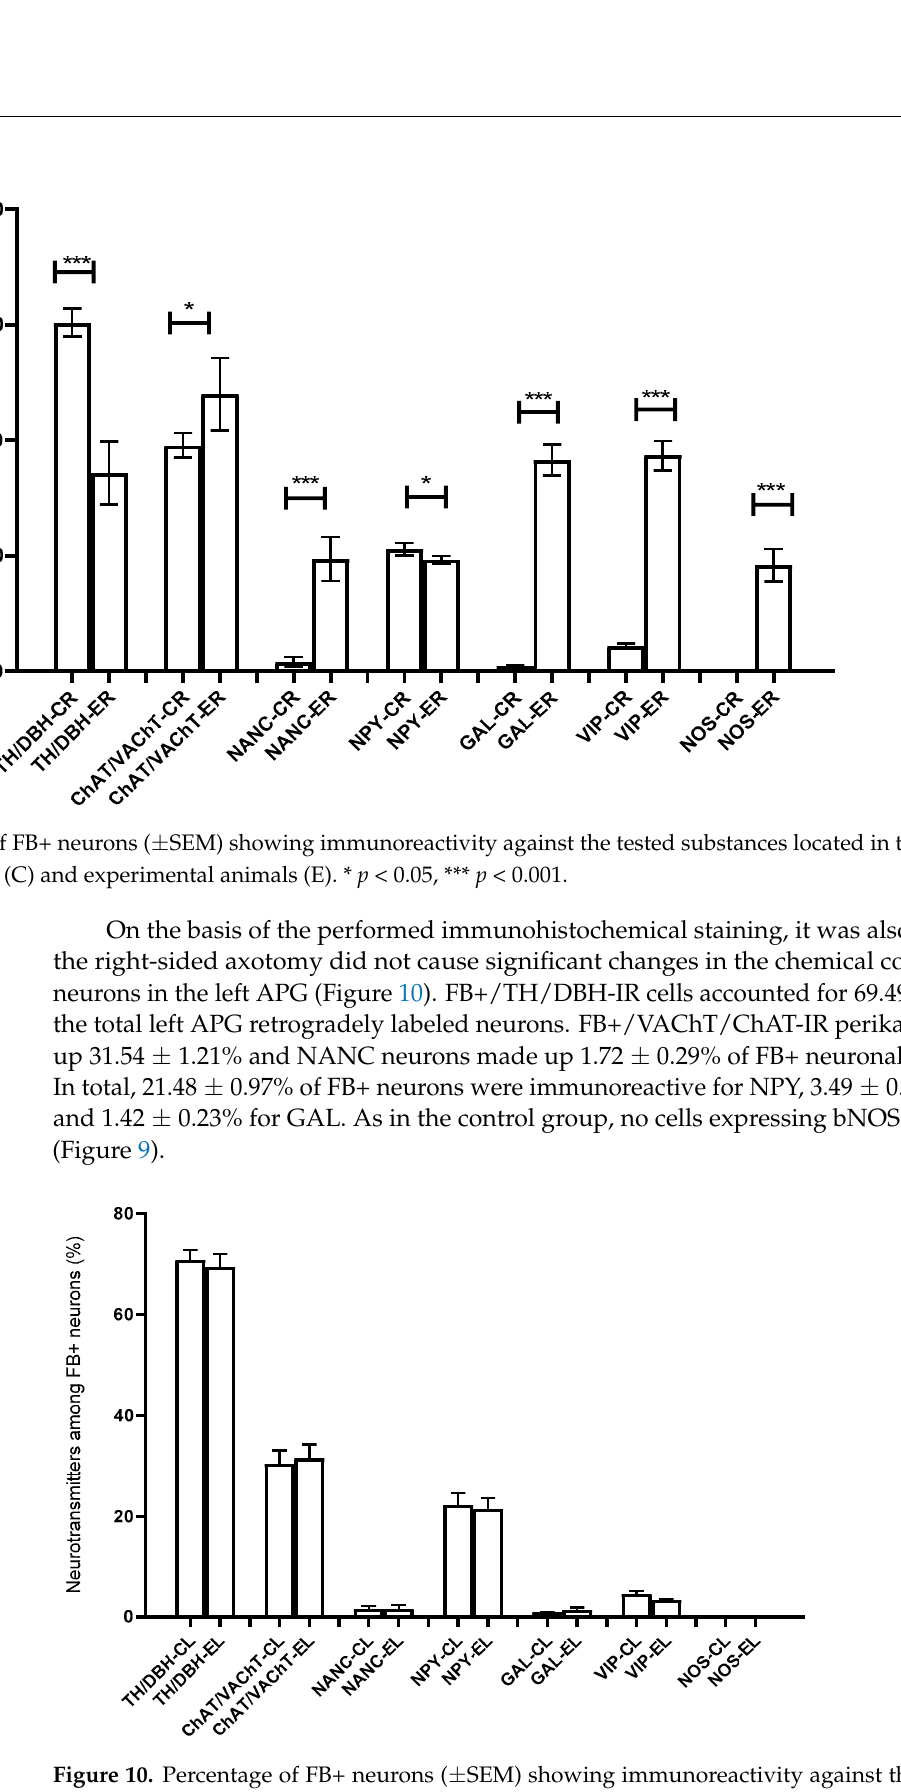
Figure 10. Percentage of FB+ neurons (±SEM) showing immunoreactivity against the tested sub- stances located in the left (L) APG of the control (C) and experimental animals (E); There were no non-statistically (ns) significant differences ( p > 0.05). non-statistically (ns) significant differences ( p >